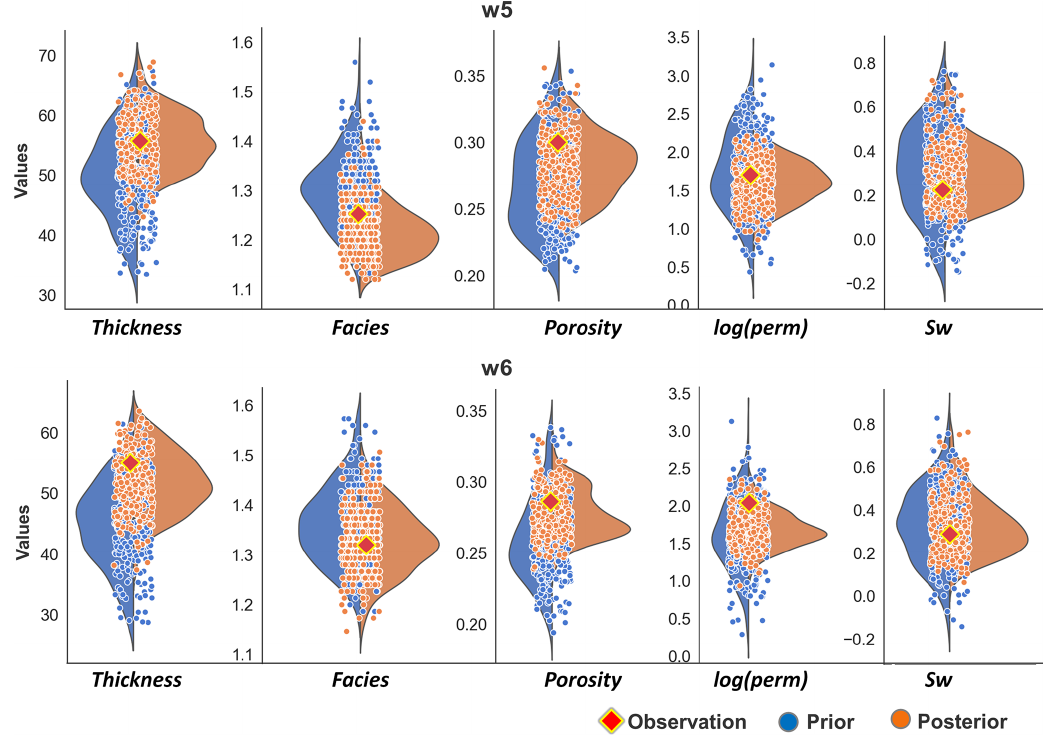
Figure 23. Prior and posterior predicted thickness, facies, porosity, log-perm, and Sw at validating boreholes. The blue and brown colored dots, respectively, represent the prior and posterior prediction, while the red squares are the actual